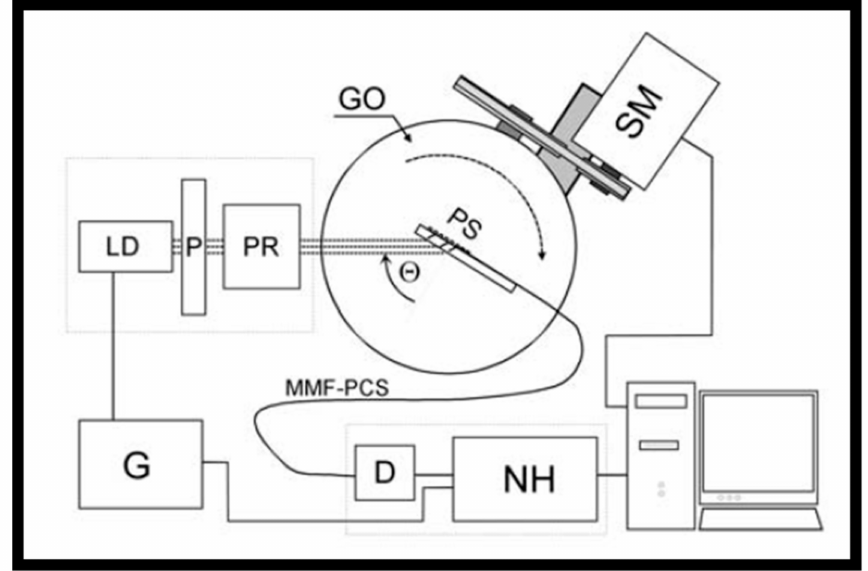
Figure 5. Schematics of the measurement setup for VGC sensors. Reprinted from ref. [57]. PS—planar structure, GO—goniometer, SM—stepping motor, LD—laser diode, P—polarizer, PR—polarizer rotator, G—generator, D—detector, NH—homodyne